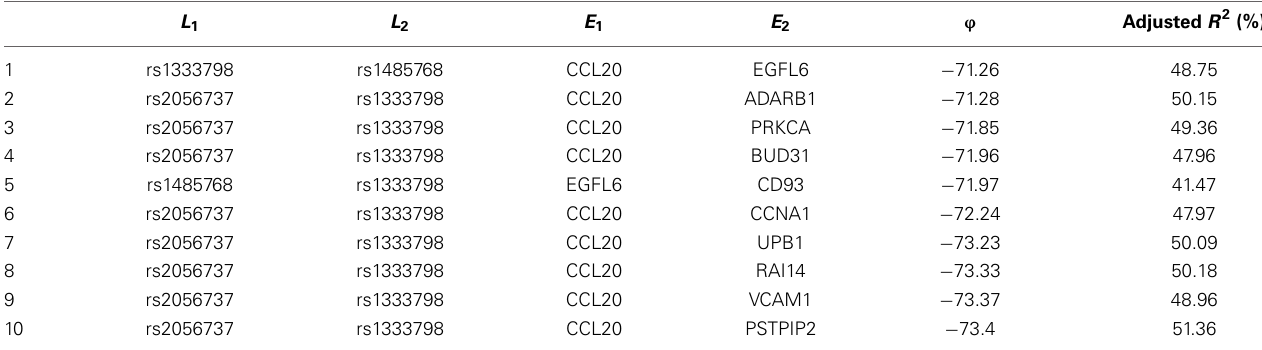
Table 3 | Top scoring five-node subnetworks for docetaxel * .